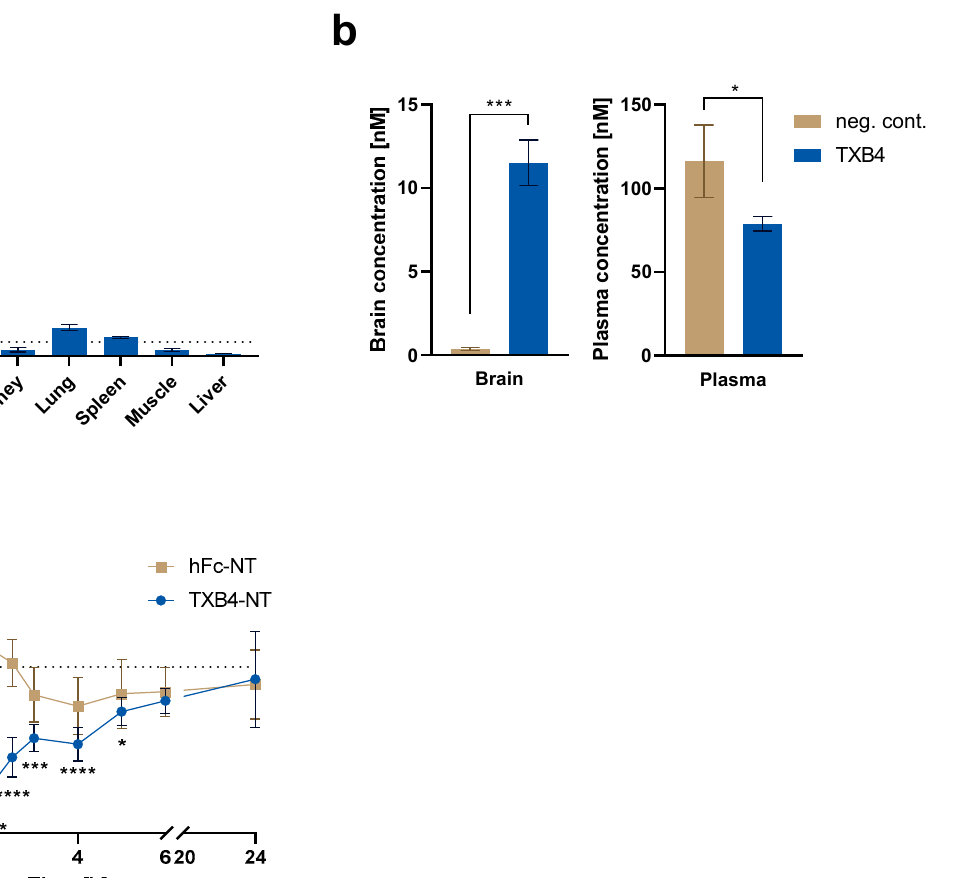
maximal − 2.9 °C drop at the 2 h timepoint (Figure 4c). The recovery from hypothermia from the 2 h timepoint onwards was consistent with the receptor desensitization and pro- teolytic cleavage of the NT peptide [23]. The NT peptide fused to the C-terminal of the hFc domain alone (hFc-NT) was used as a control and when dosed at the same concentra- tion it failed to elicit a physiological response.